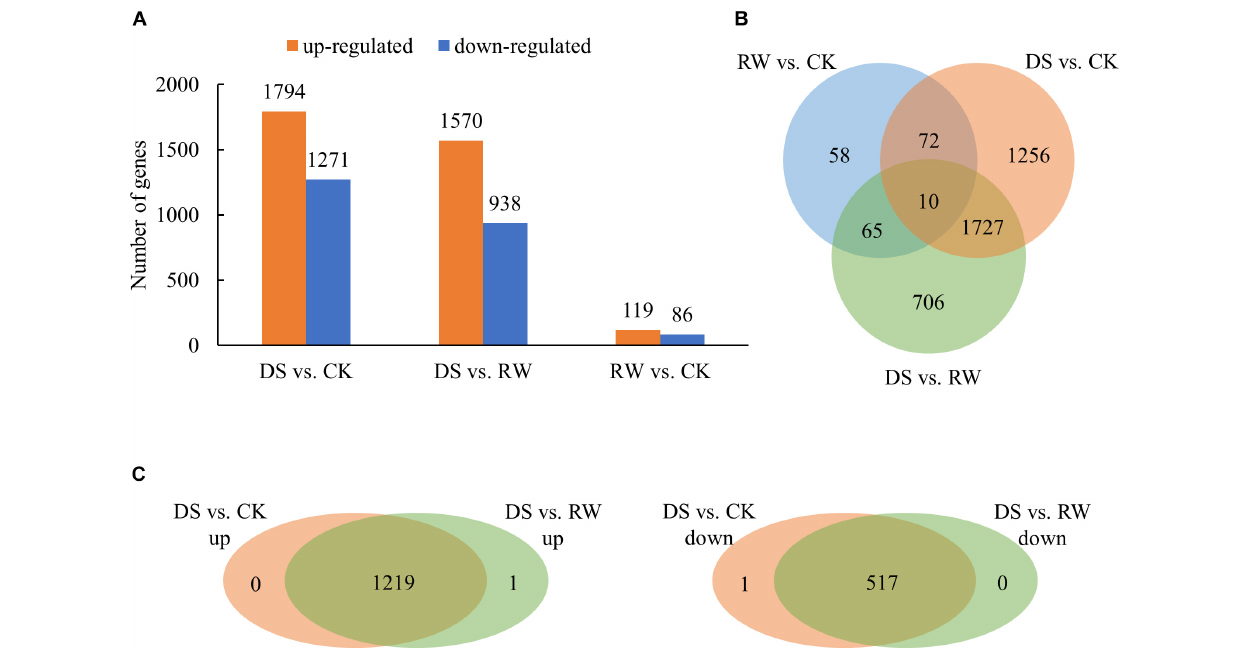
FIGURE 1 | Differentially expressed gene analysis for control (CK), drought stress (DS), and rewatering (RW) treatment in M. ruthenica . (A) The number of DEGs for the DS vs. CK, DS vs. RW, and RW vs. CK comparisons ( p < 0.05); orange, upregulated DEGs; blue, downregulated DEGs. (B) Venn diagram of overlapping DEGs among the three comparisons. (C) Venn diagrams to illustrate the overlapping DEGs with upregulated expression between the DS vs. CK comparison and the DS vs. RW comparison, and the overlapping DEGs with downregulated expression.